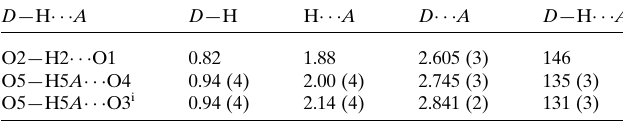
Table 2 Hydrogen-bond geometry (A˚ , (cid:2) ) for ( 2 ).